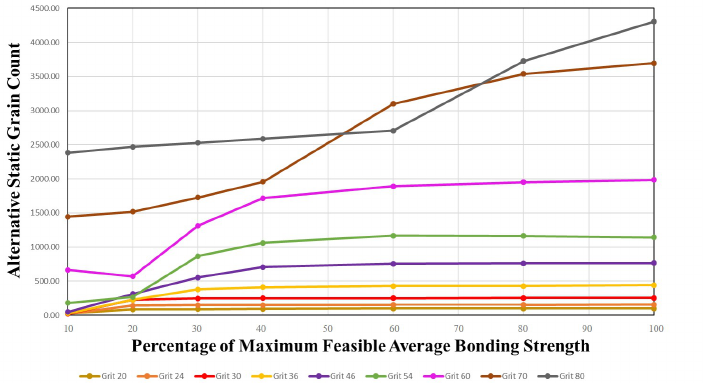
Figure 21. Alternative static grain count dependent on different percentages of maximum feasible average bonding